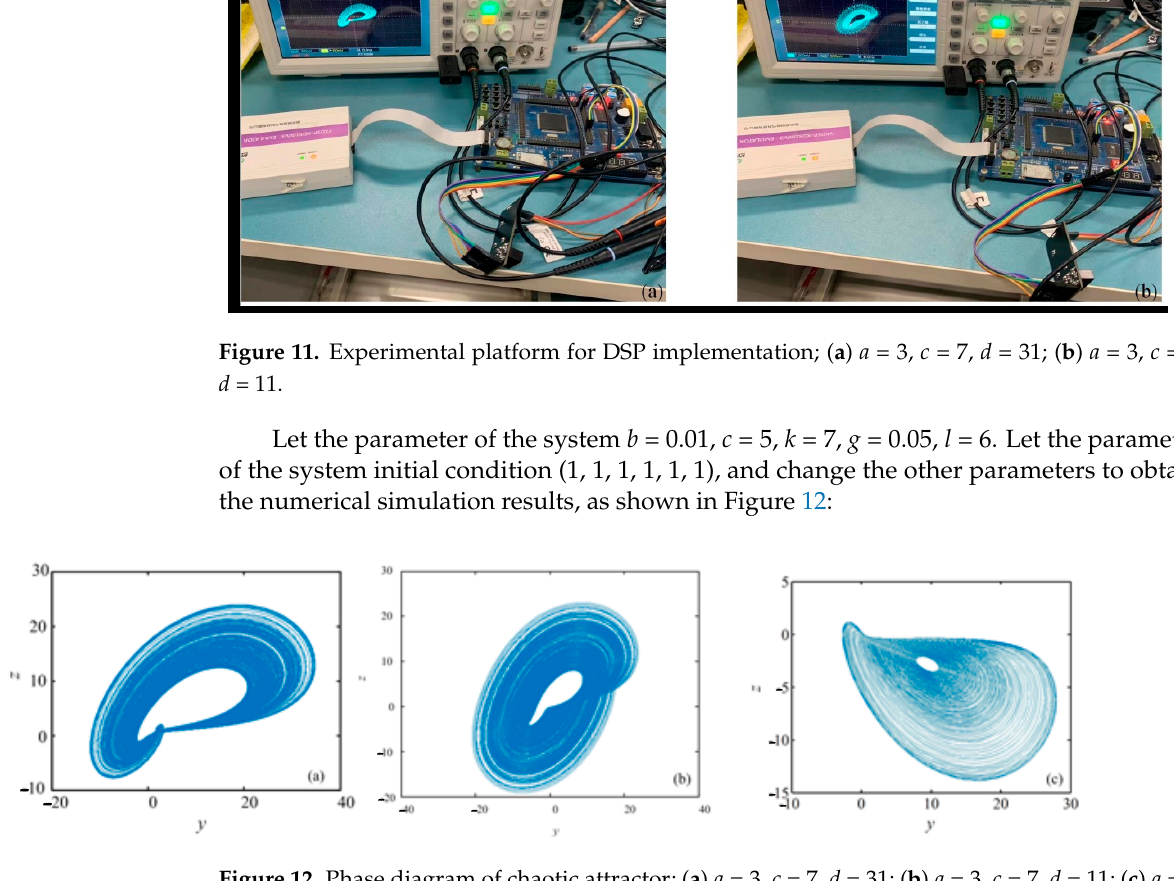
Figure 10. Programming flow of DSP implementation.